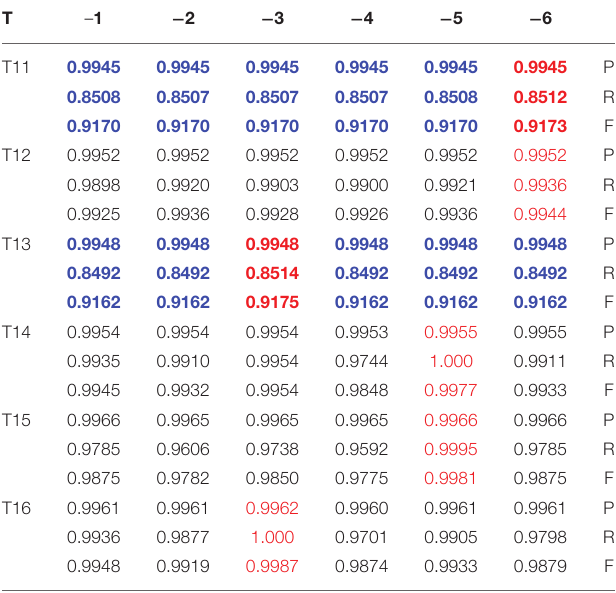
The red color indicates the best value and blue color indicates next best value for different parameters that do not change.